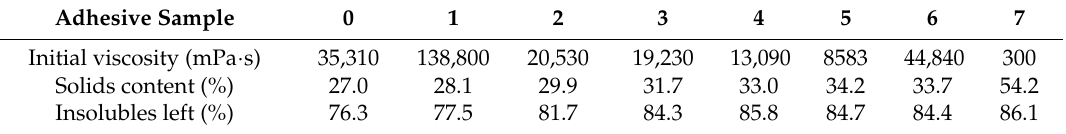
Table 3. The viscosity at 1 s − 1 shear rate, the solids content and insolubles left of the different adhesives: 0 (SM adhesive), 1 (SM/SDS adhesive), 2 (SM/SDS/NGDE-2 adhesive), 3 (SM/SDS/NGDE-4 adhesive), 4 (SM/SDS/NGDE-6 adhesive), and 5 (SM/SDS/NGDE-8 adhesive), 6 (SM/PAE